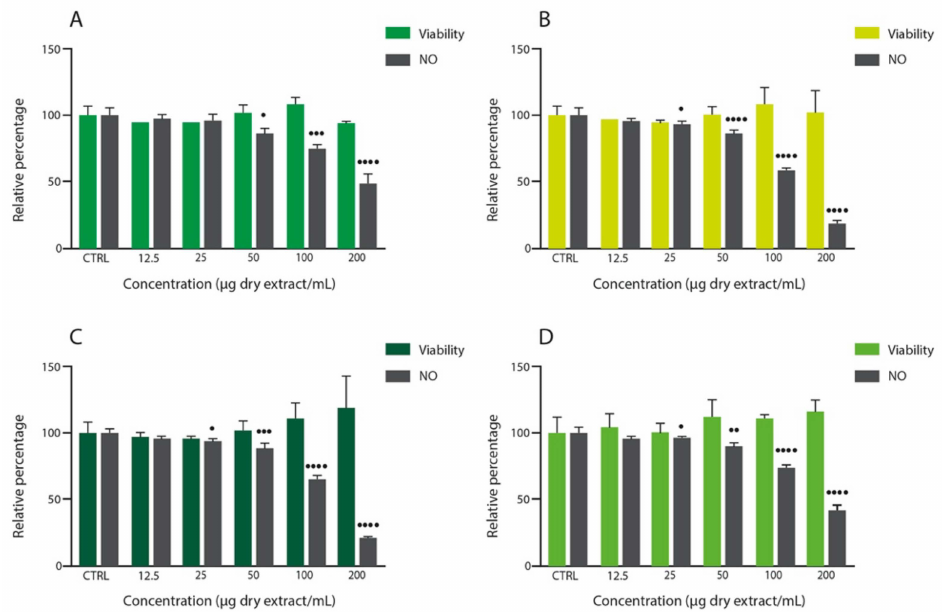
Figure 4. ( A – D ) Relative percentage of NO production by RAW 264.7 and the viability of cells in the presence of B. monnieri extracts at different concentrations. ( A ) BH, ( B ) BS, ( C ) BE and ( D ) BX. Results are expressed as a % of NO production and cell viability relative to the control. Results